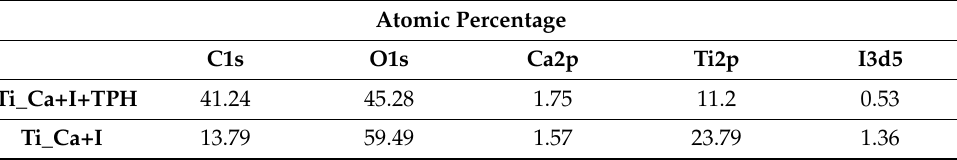
Table 1. The atomic percentages of the elements detected on the surface of samples Ti_Ca+I+TPH and